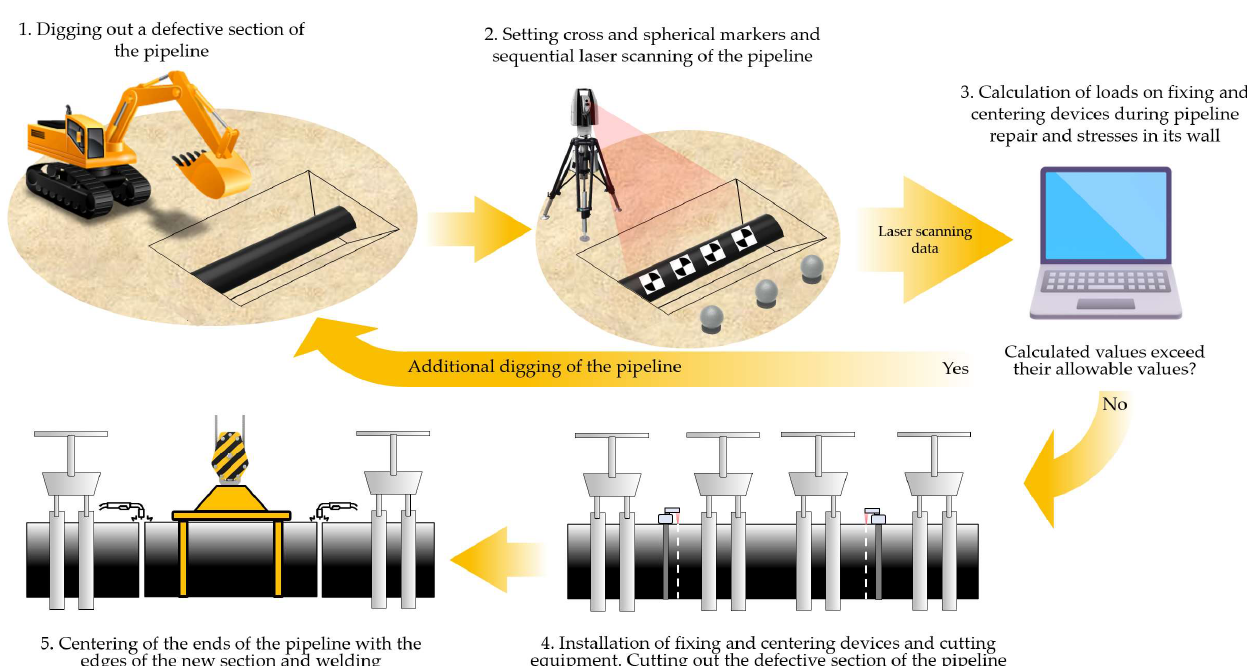
Figure 1. The flowchart of the developed repair method.